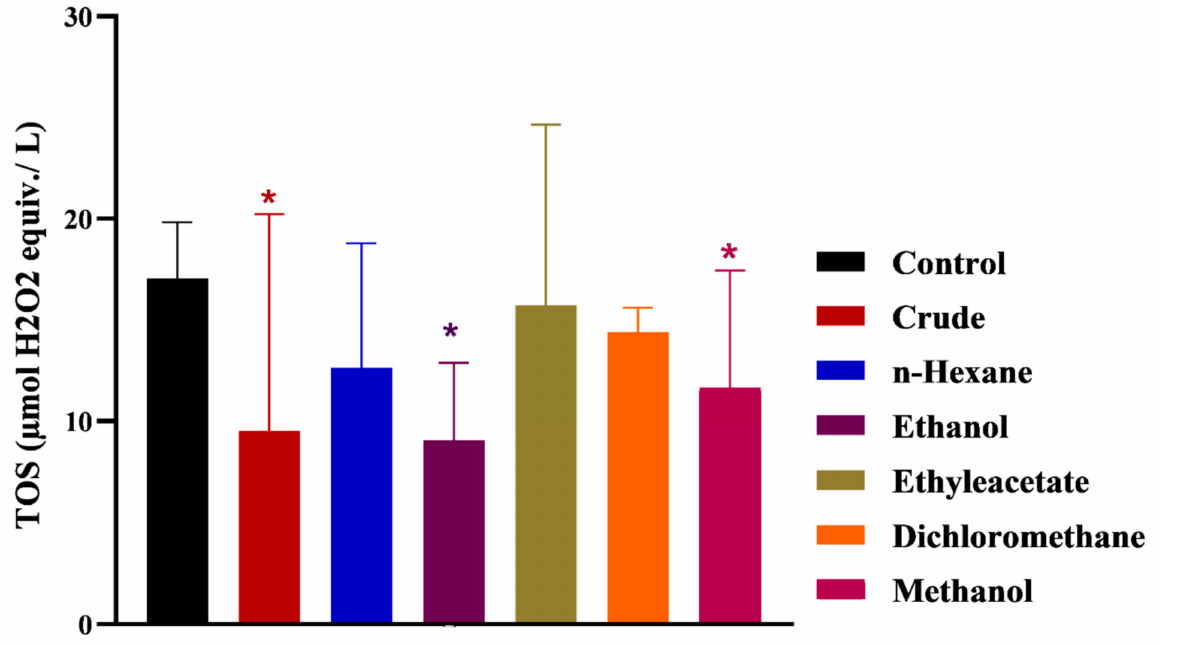
Figure 6. Effects of M. oleifera on total oxidant status following sciatic nerve lesion. * show the significance of results statistically.